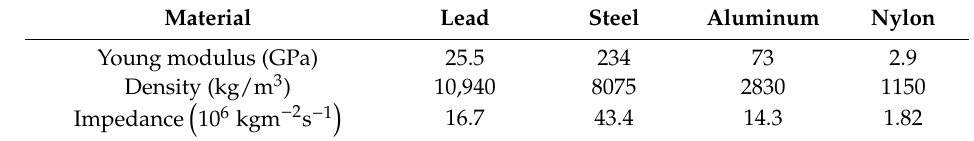
Figure 7. Signal transmission in SHPB setup. Table 5. Impedances for di ff erent